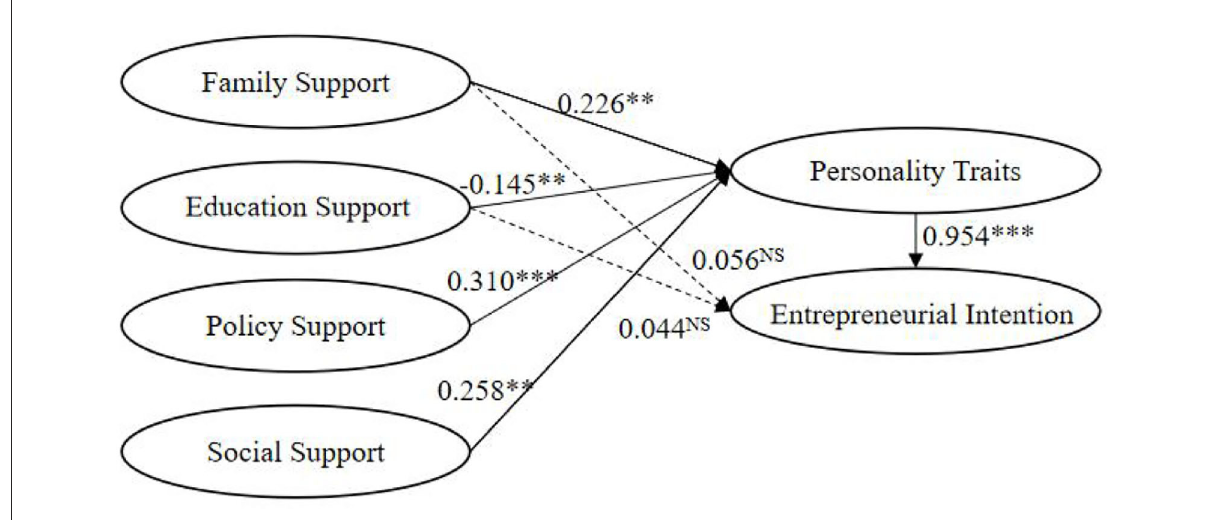
FIGURE2 Path of SEM from research. NS, not significant; *** P < 0.001; ** P <